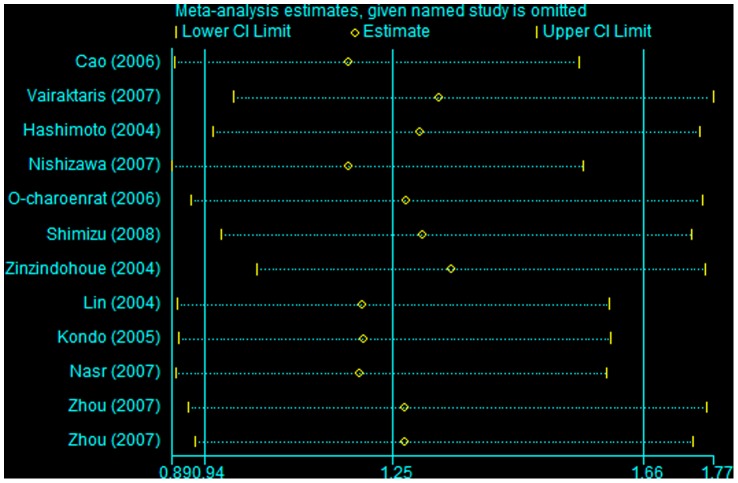
Sensitivity analysis through deletion of one study at a time to reflect the influence of the individual dataset to the pooled ORs under the dominant model.